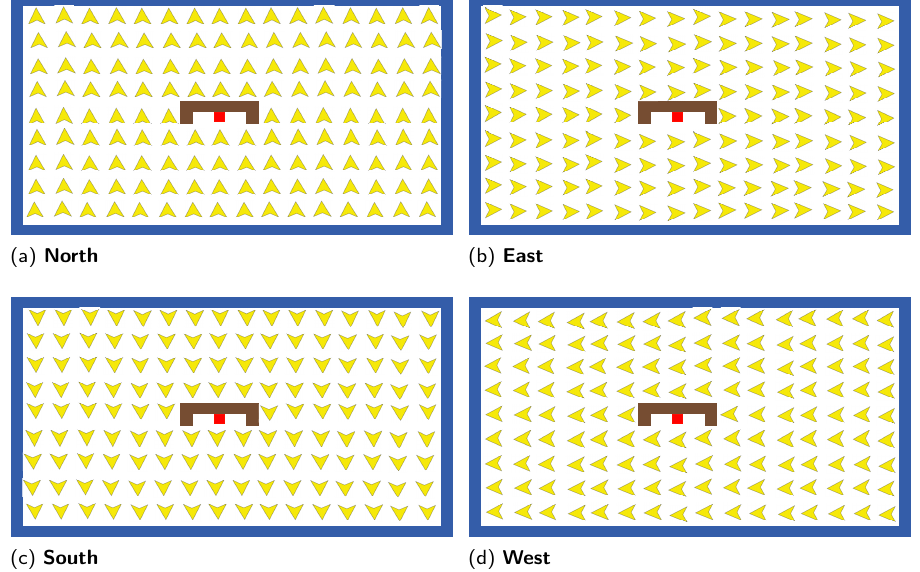
Figure 9. Representation of all locations in the navigation environment where a GE-system was run 30 times from each of four different